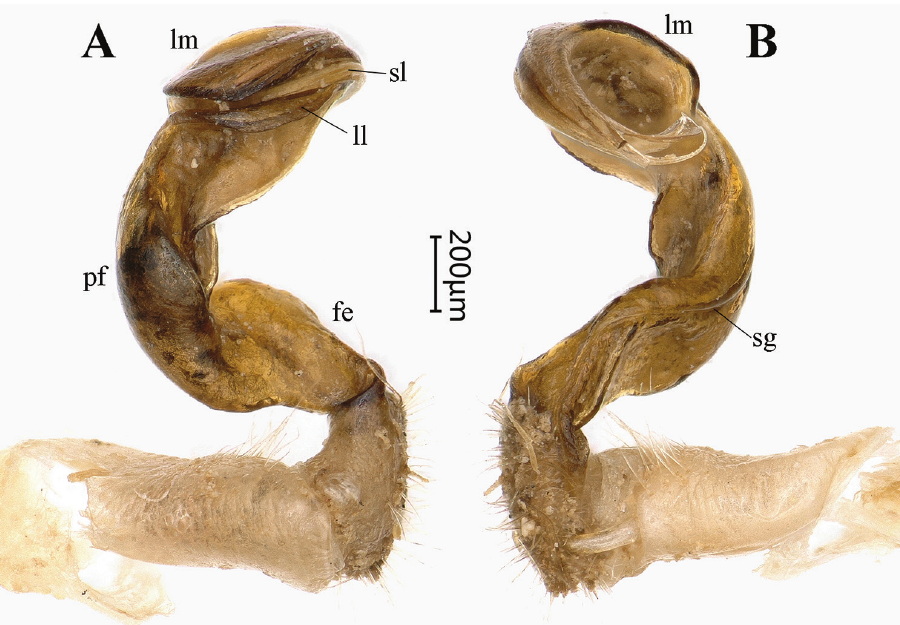
Figure 3. Tonkinosoma flexipes Jeekel, 1953, ♂ . A, B right gonopod, lateral and mesal views, respectively. Abbreviations: fe = femorite; ll = lamella lateralis; lm = lamella medialis; pf = postfemur; sg = seminal groove; sl =